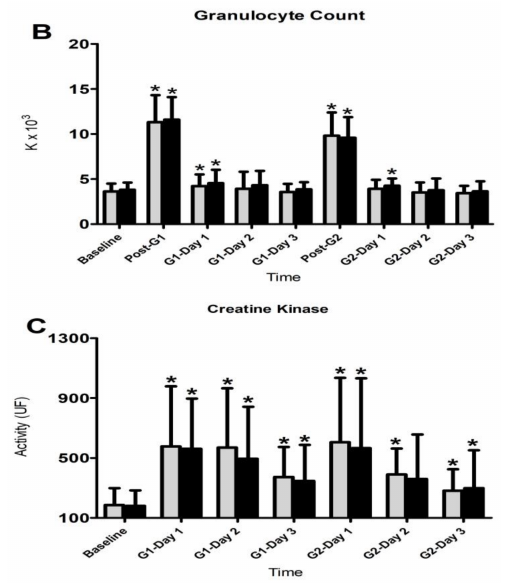
Figure 4. Changes in WBC count ( A ), granulocyte count ( B ), and creatine kinase activity (C). G1, game 1; G2, game 2; * denotes a significant difference with baseline at p < 0.05.